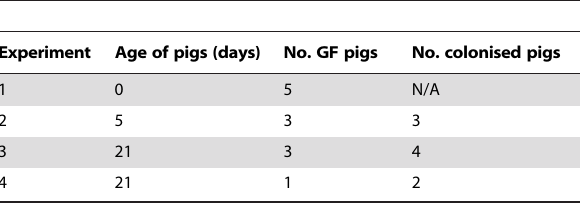
Table 1. Numbers and ages of GF and colonised pigs in each